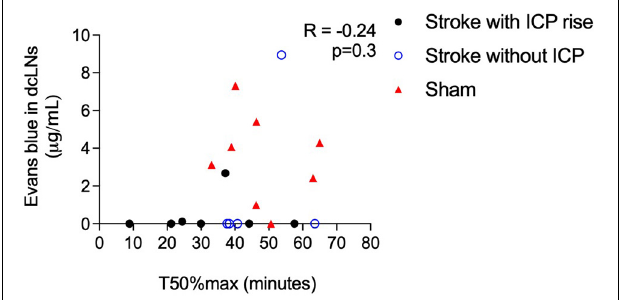
FIGURE 6 | Correlation between speed of CSF transit to the spinal subarachnoid space (T50%max) and concentration of Evans blue dye in deep cervical lymph nodes (dcLNs; µ g/ml) in stroke animals with intracranial pressure (ICP) rise greater than +4.4 mmHg (black closed circles), without ICP rise (blue open circles), and sham animals (red triangles). A Spearman correlation was used for analyses.